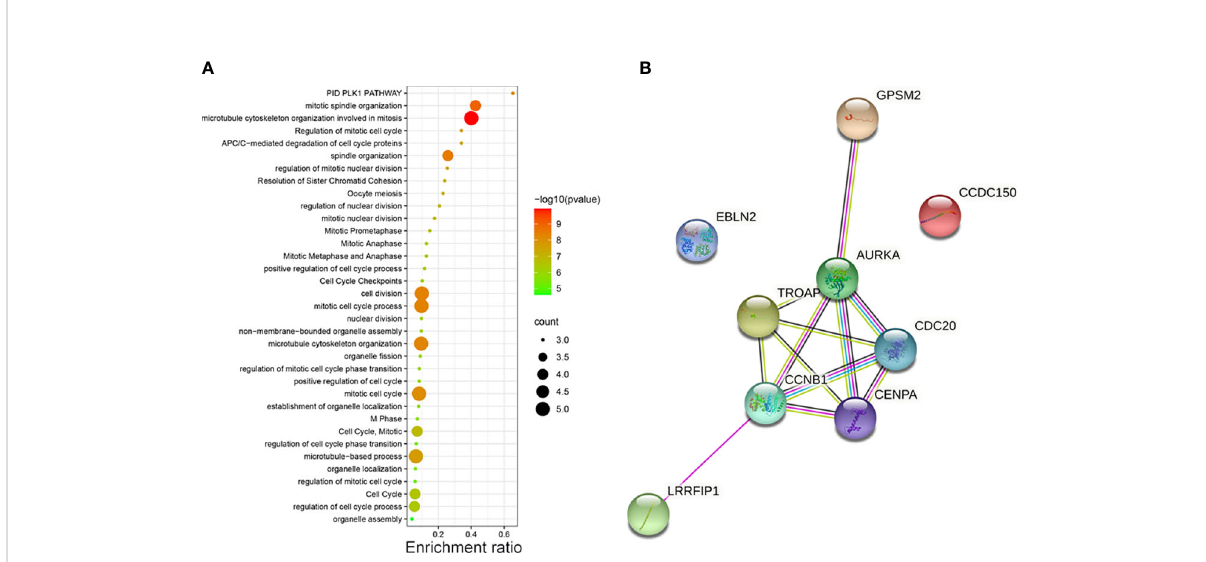
FIGURE 2 (A) The pathways of vinblastine resistance-related genes depending on Metascape. (B) The PPI network re fl ects the association between each hub genes.